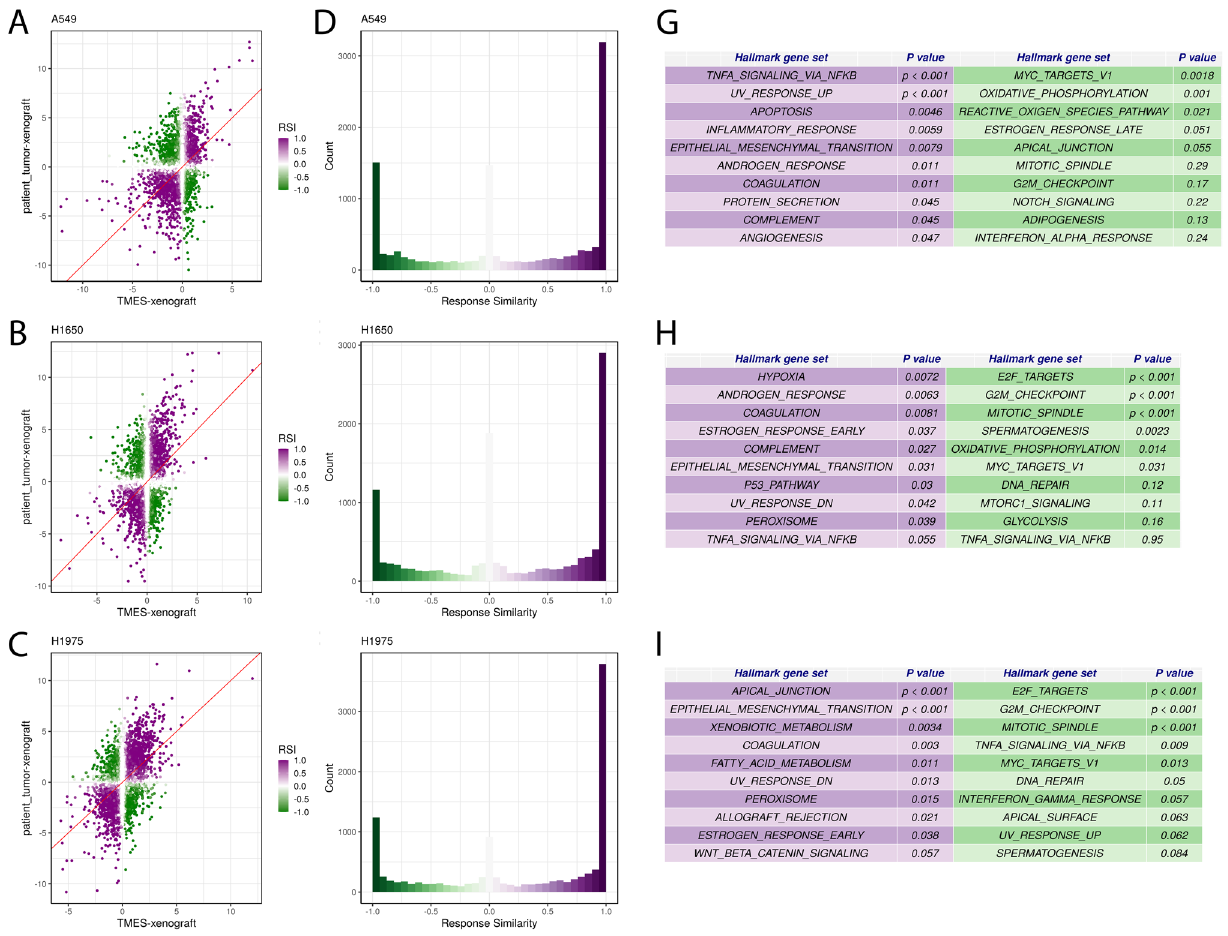
Figure 6. Response Similarity Analysis of NSCLC cell lines relative to patient tumors. ( A – C ) Xenograft vs TMES scatterplots log2 fold changes relative to patient tumors with the same genetic driver mutation. Points are colored by their response similarity (RSI), where darker, more saturated colors indicate transcripts that show greater evidence for joint differential expression on both axes. Purple indicates transcripts that are concordantly regulated between the two conditions, whereas green indicates discordance. ( D – F ) Histograms of RSI values in ( A – C ). ( G – I ) Top ten concordantly (purple) and discordantly (green) regulated hallmark statistical intersection–union test to identify both concordant and discordant differential expression. We com- pared the gene expression of patients in the NSCLC TCGA with the corresponding driver mutation (RAS mutant for A549, EGFR mutant exon 19 del(E746-A750) for H1650, and EGFR mutant L858R for H1975) to NSCLC cells grown in the TMES or as a xenograft (Fig. 6). We found that in terms of deviations from xenograft samples, patient tumors and TMES samples are more similar than different (Fig. 6D–F), with many transcripts showing highly concordant responses (Fig. 6A–C). A pathway analysis based on the Hallmark gene sets used above shows that concordantly and discordantly regulated genes have limited functional coherence (Fig. 6G–I). These data further demonstrate that the TMES recapitulates many of the transcriptional characteristics of patient tumors, and suggests that the TMES may better reflect the patient biological state than xenografts. The transcriptomic analysis collectively indicates that tumor cells grown in the TMES reflect the biology of NSCLC patient tumors. This leads to the prediction that tumor cell growth in the TMES should be controlled using standard of care chemotherapeutics at concentrations equivalent to typical concentration attained in patients. We evaluated the efficacy of two standard of care chemotherapeutic combinations used for the treatment of NSCLC; the combination of gemcitabine (35.4 μM) and cisplatin (6.5 μM), and the combination of paclitaxel (6.2 μM) and carboplatin (67 μM) on the three NSCLC cell lines in the TMES (Fig. 7). The drug concentrations used in our stud- ies were based on the patient dosing in the INTACT1 and INTACT2 clinical trials 51,52 . Patients in the INTACT1 trial were treated with 1250 mg/m(2), IV/30 min infusion of gemcitabine and 80 mg/m(2) of cisplatin yielding a plasma C 67 μM for carboplatin 54,57–59 . As we have done previously, we assessed the efficacy of these drug combinations on growth, following three days of drug exposure after tumor cell biology had been established in the TMES 25 . The